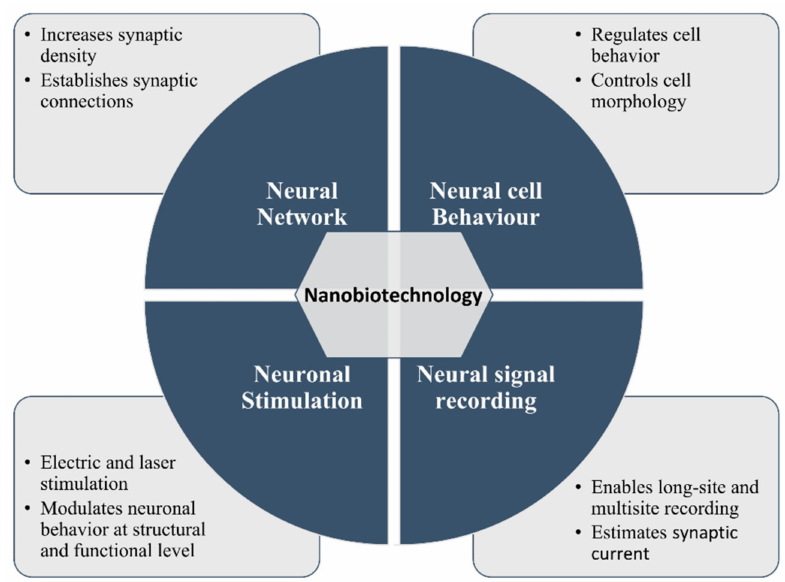
Figure 1. Illustration of nano-biotechnological approaches for neuroscience